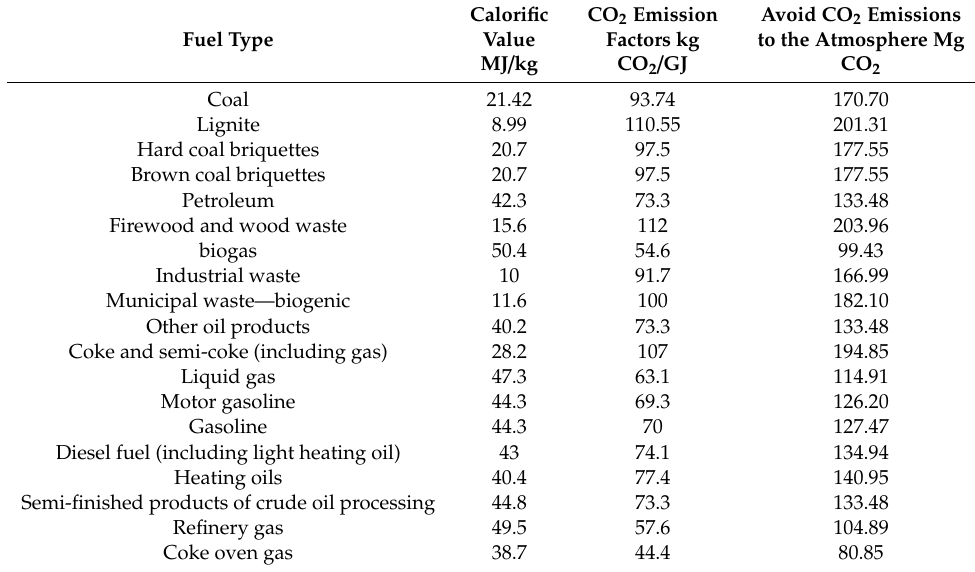
Table 7. Avoided CO 2 emissions to the atmosphere.